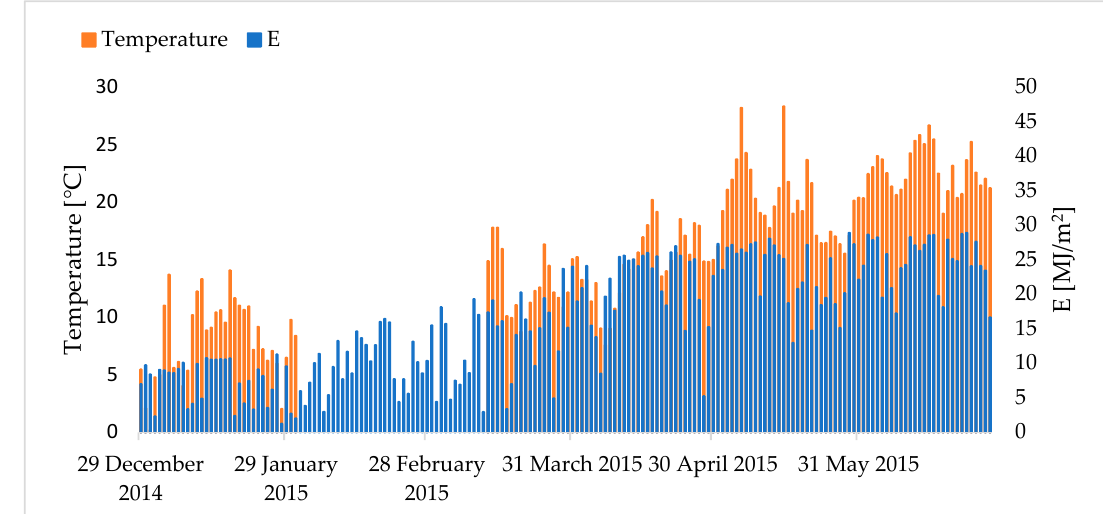
Figure 1. Relevant meteorological parameters (i.e., temperature and solar radiation) monitored during the field survey.